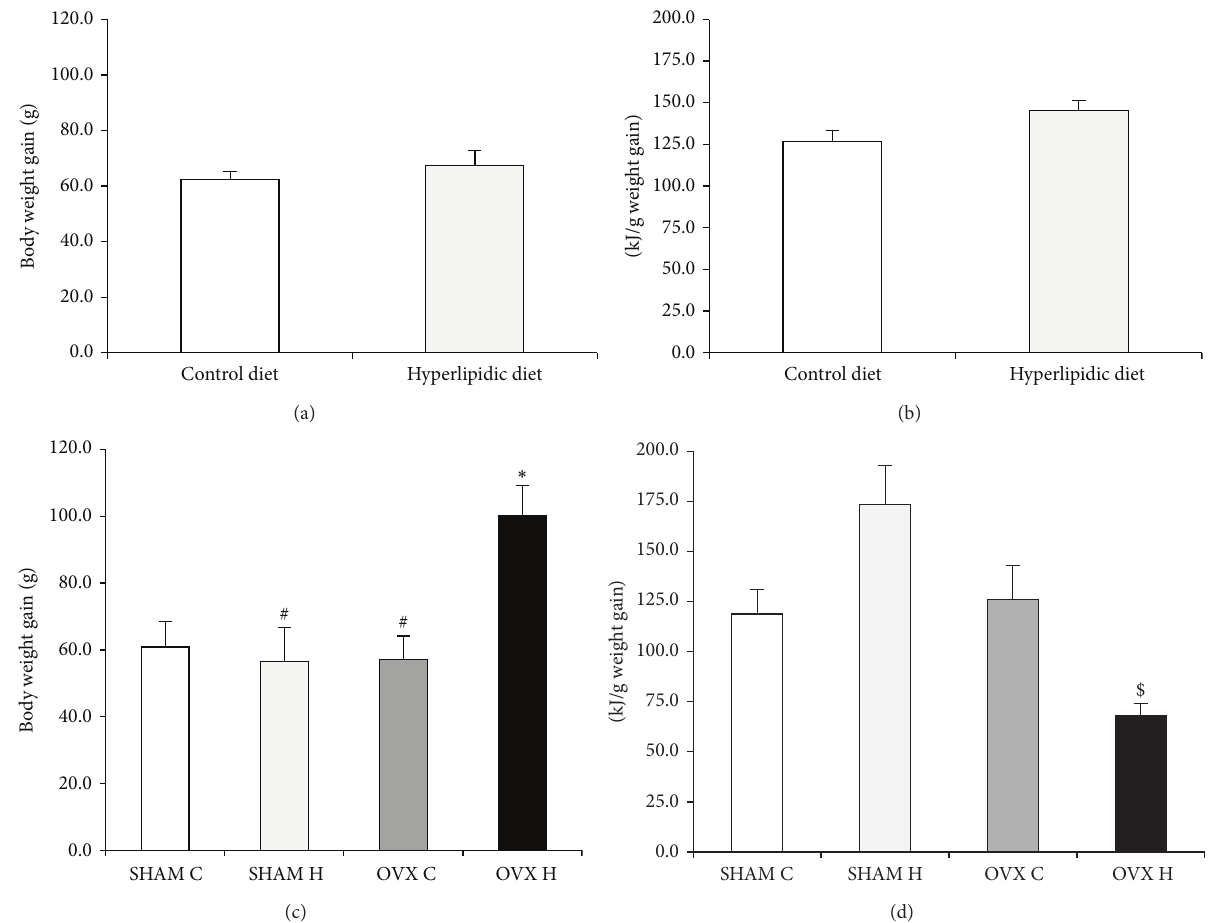
Figure 1: Body weight gain after four weeks of control diet (number of animals is 15) or hyperlipidic diet (number of animals is 13) (a) and after four weeks of ovariectomy (b) of studied rats groups: (SHAM C) sham group treated with control diet; (SHAM H) sham group treated with hyperlipidic diet; (OVX C) ovariectomized group treated with control diet; (OVX H) ovariectomized group treated with hyperlipidic diet. The numbers of animals varied between six and eight. ∗ 𝑃 < 0.05 as compared to the SHAM C; # 𝑃 < 0.05 as compared to OVX H; $ 𝑃 < 0.05 as compared to SHAM